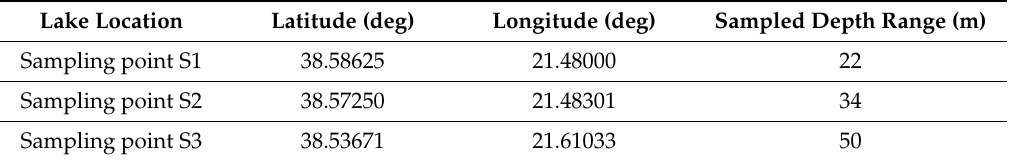
Table 1. Locations of the 3 sampling stations in Lake